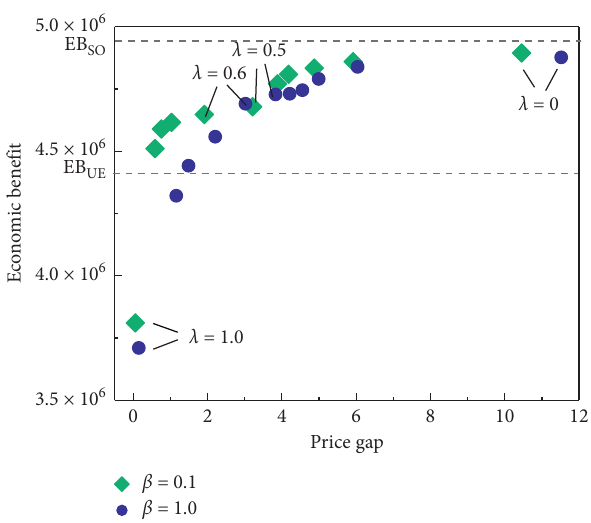
Figure 8: Pareto frontiers for the Sioux Falls